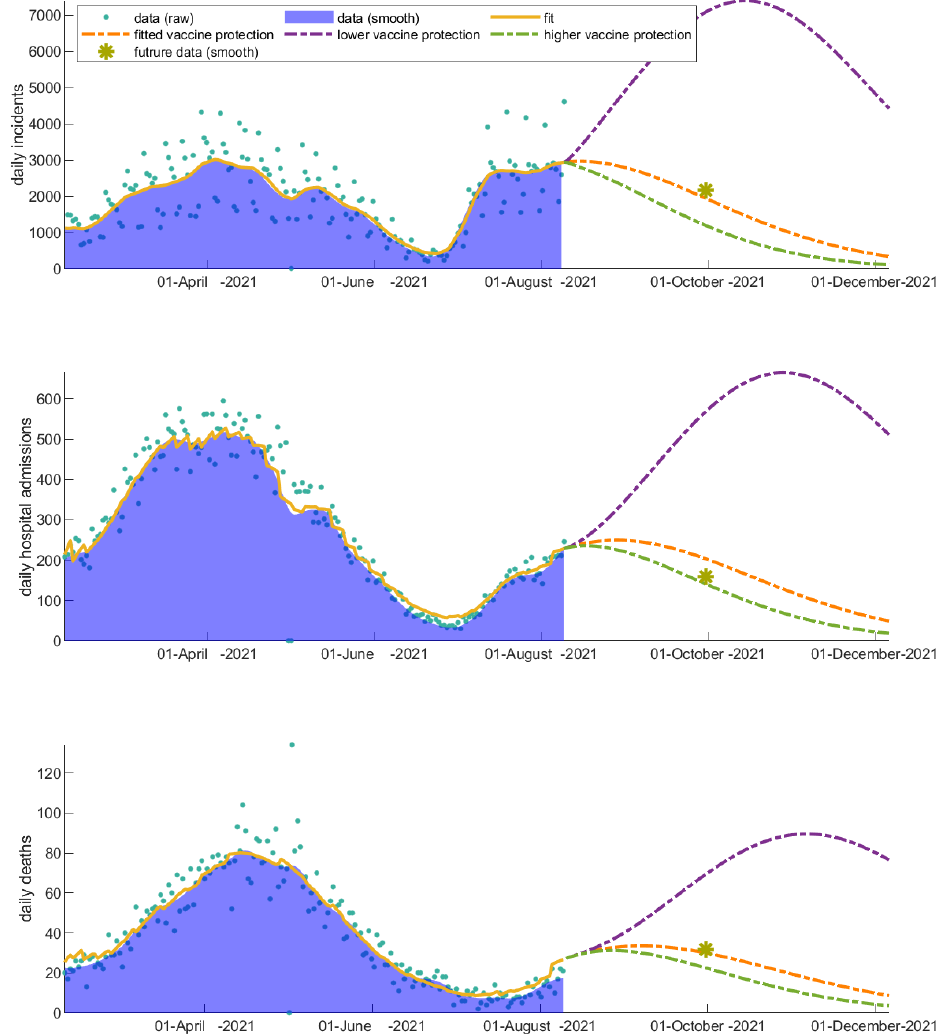
Figure 5. Impact of vaccine effectiveness against infection and transmission on driving the disease dynamics after 10 August 2021. The daily (a) incidents, (b) hospital admissions, and (c) deaths are considerably affected indicating the importance of self-awareness in vaccinated individuals. An indicative data point from the future (1 October 2021) is shown with a yellow asterisk for